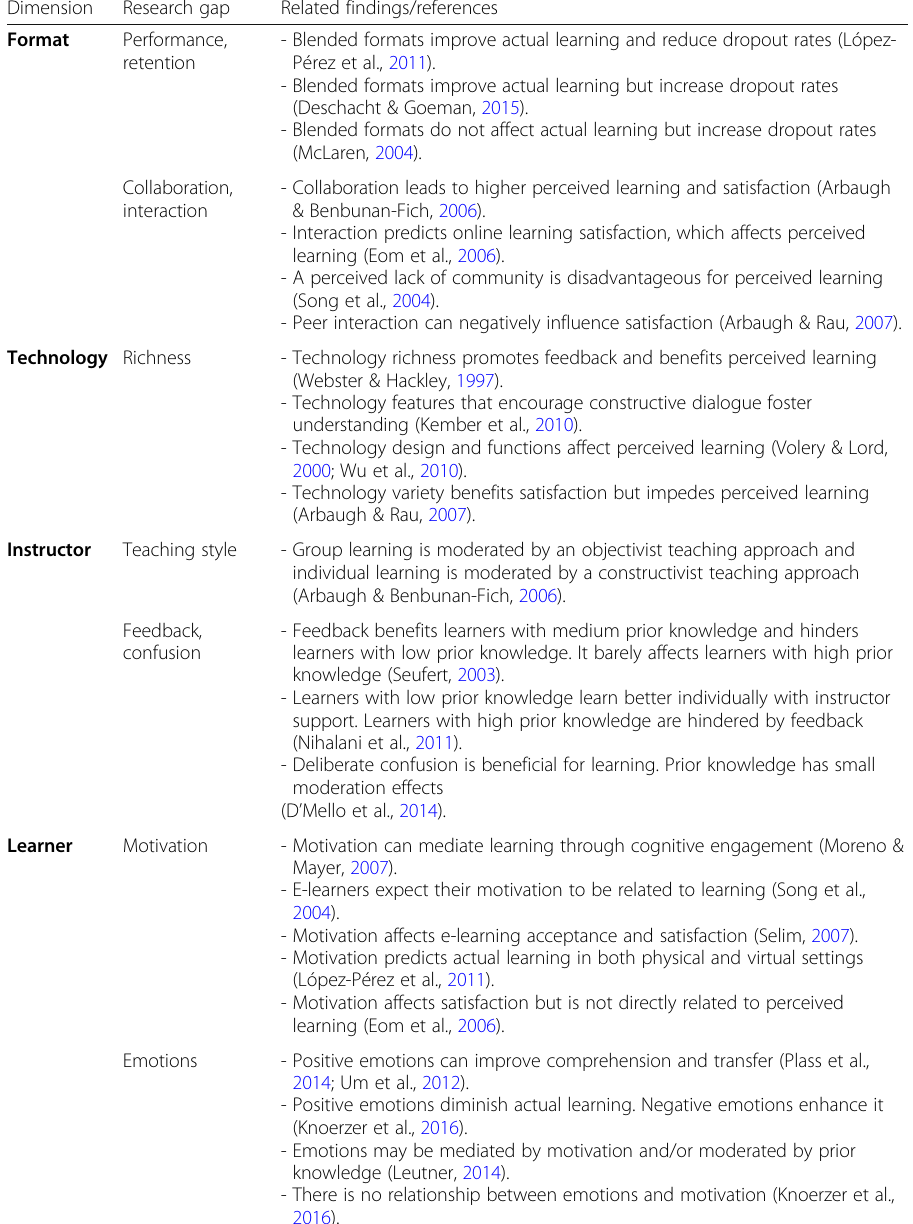
Table 2 Selected Opportunities for Further Research Dimension Research gap Related